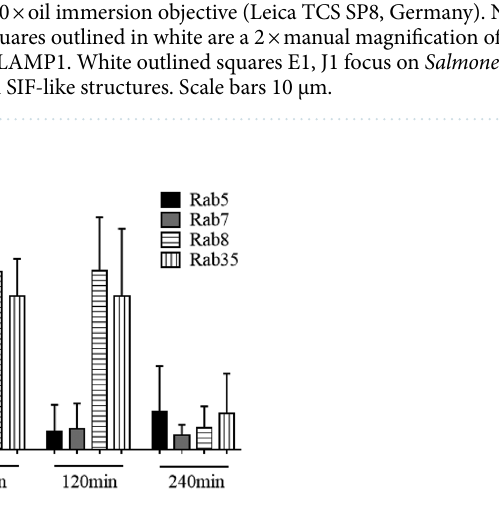
Figure 9. Salmonella containing vacuole associated with Rab GTPase markers. The localization of Rab GTPase to SCV from AML12 cells infected by ST DsRed at 10 min, 30 min, 60 min, 120 min and 240 min was estimated by labelling purified SCV with (black bar) mouse Rab5 antibody, (grey bar) mouse Rab7 antibody, (horizontal line bar) rabbit Rab8 antibody or (vertical line bar) rabbit Rab35 antibody revealed with anti-mouse Alexa Fluor 488 and anti-rabbit Alexa Fluor 488, respectively. Acquisition of SCV events were discriminated from PNS based on DsRed fluorescence using cytometry (BD LSRFortessa X-20 cell analyzer) and analyzed using FCS Express 4 Flow. Data are the means and standard deviations from three independent triplicates